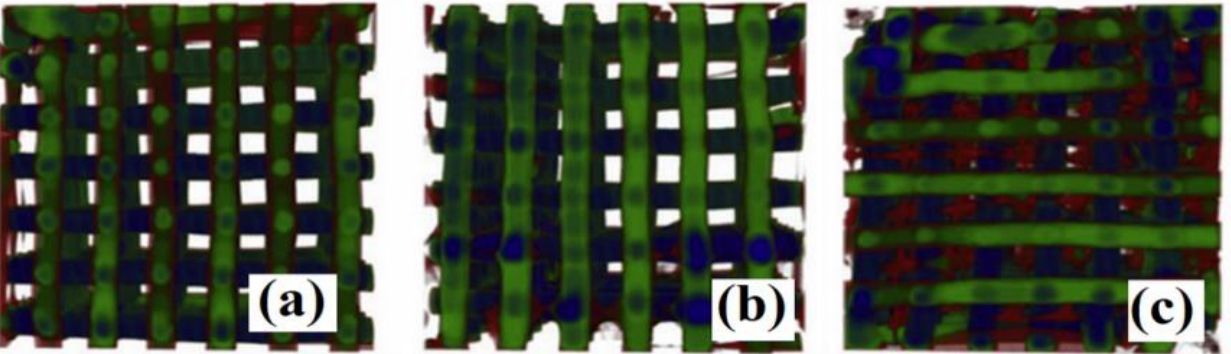
Figure 5. Three-dimensional distribution of poly- ε -caprolactone support from thin (red) to medium (green) and to thick (blue) for: unmodified ( a ), functionalized by a bismethacrylate polymer network ( b ), and final MIP material ( c ). Adapted with permission from Reference [94]. Elsevier, 2017.